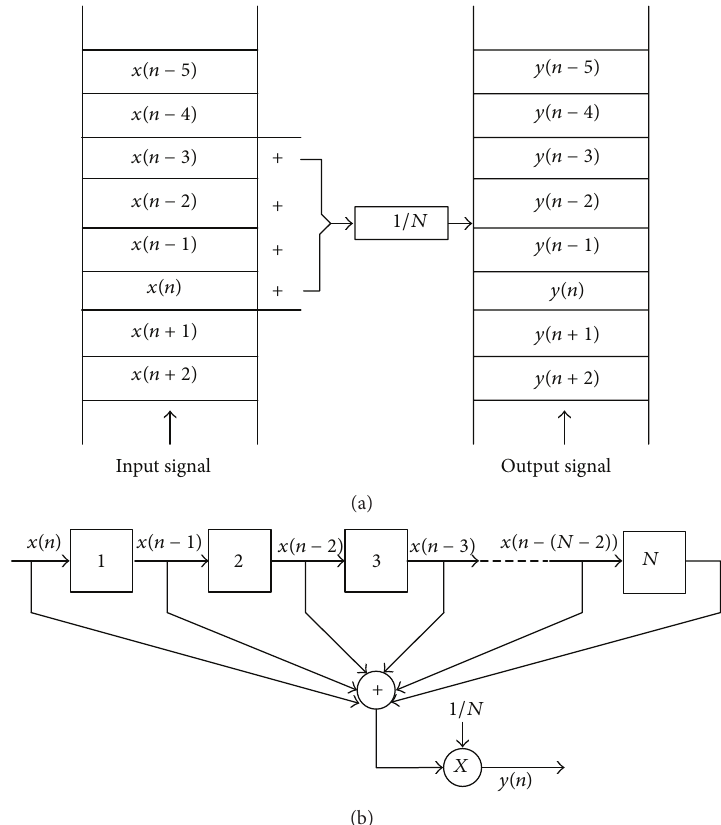
Figure 3: (a) Moving average circuit. (b) Block diagram of 𝑁 -order simple moving average (SMA) circuit.